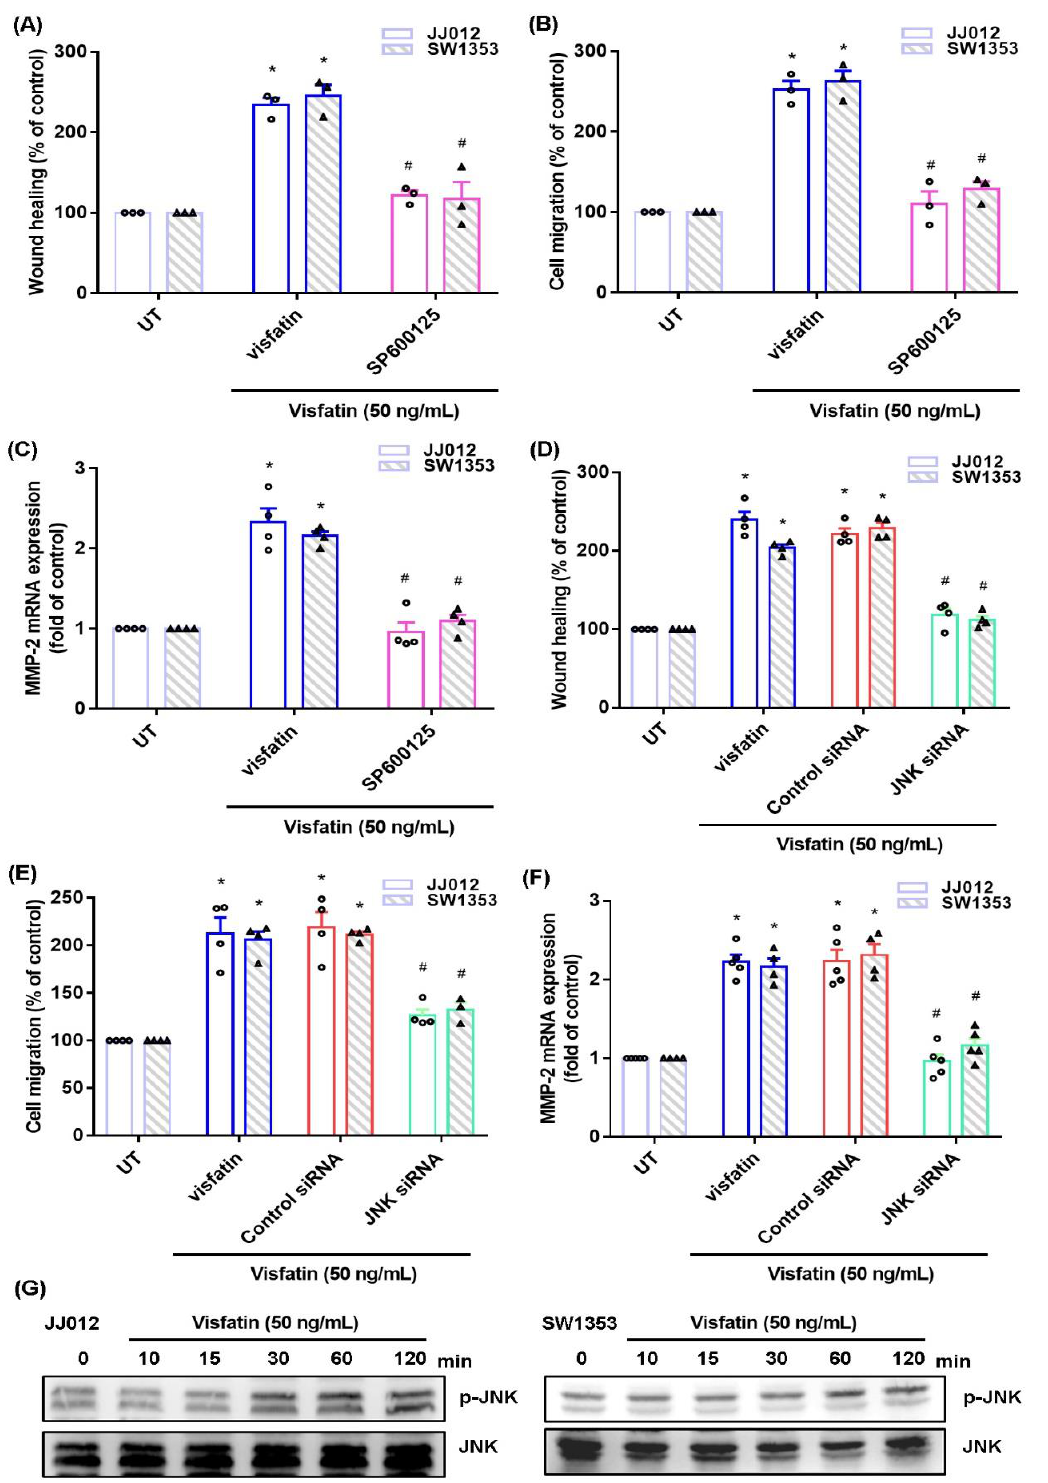
Figure 4. The JNK pathway mediates visfatin-induced MMP-2 expression and cell migration. ( A – F ) Cells were pretreated with a JNK inhibitor (SP600125) or transfected with a JNK siRNA, then stimulated with visfatin. Cell migration and levels of MMP-2 expression were examined by Transwell, wound healing, and qPCR. ( G ) Cells were incubated with visfatin for the indicated time intervals; JNK phosphorylation was examined by Western blot. Quantitative results are expressed as the mean ± SD. All experiments were repeated 3 to 5 times. * p < 0.05 compared with the UT group; # p < 0.05 compared with the visfatin-treated group. UT, untreated